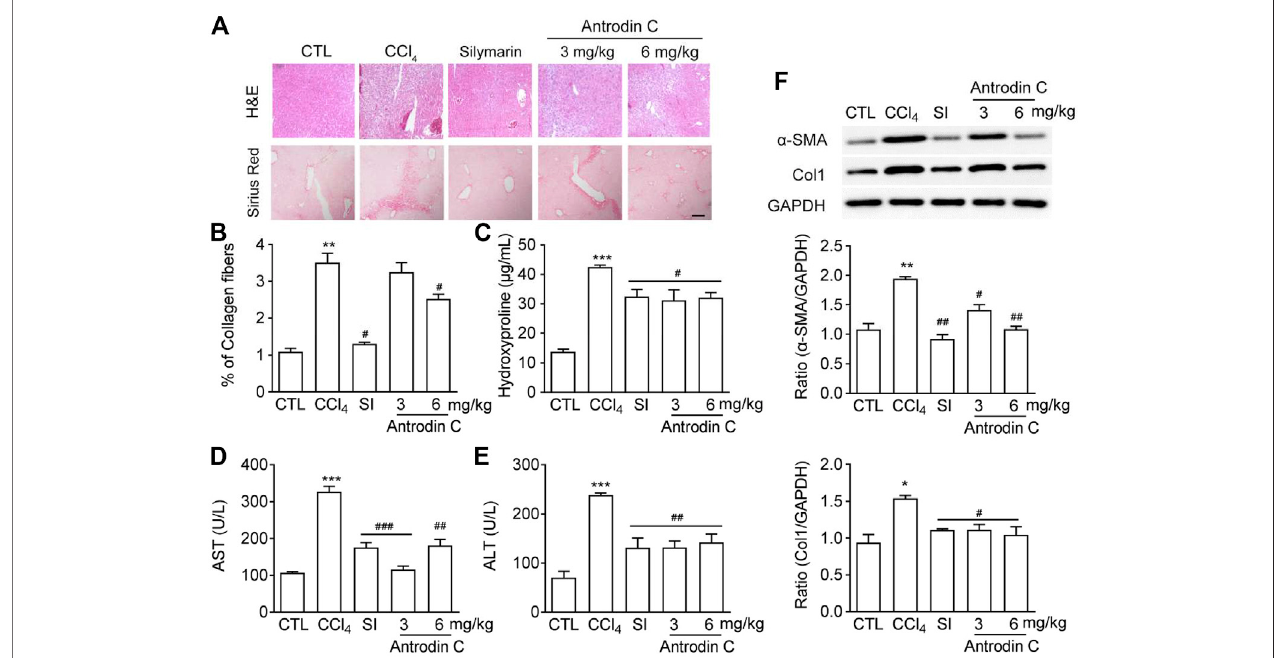
FIGURE6| Effects ofAntrodinC onliver fi brosis inducedbyCCl 4 in vivo . (A) Representative images ofH&Eand Sirius Redstainingofliver tissue sections from the different treatment groups. Scale bar, 100 μ m. (B) The Sirius red staining was normalized to % of collagen fi bers of the control group. (C) Hydroxyproline contents, (D) ALTand (E) ASTactivityinserumofCCl 4 -inducedmiceorcontrolmice. (F) Westernblotanalysisof α -SMAandCol1expressioninliverstissues.GAPDHwasusedasan internal control. Data represent means ± SD ( n = 6), * p < 0.05, ** p < 0.01, *** p < 0.001 compared with control group; # p < 0.05, ## p < 0.01, ### p < 0.001 compared with CCl 4 -treated group. CTL: the control group; CCl 4 : the CCl 4 treated group; SI: the Silymarin treated